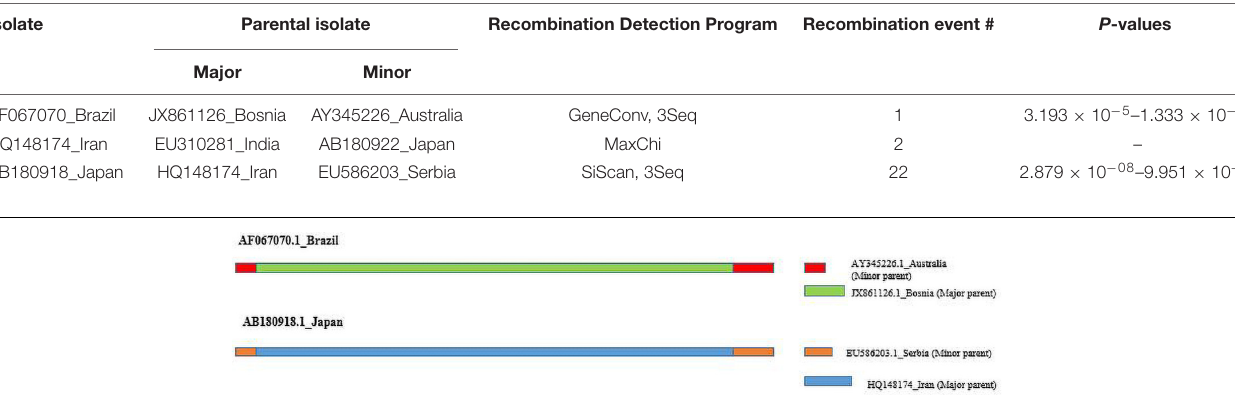
FIGURE 4 | Potential recombinants detected in Iris yellow spot orthotospovirus nucleocapsid (N) gene by Recombination Detection Program (RDP4). Major and Minor parent for each recombinants are